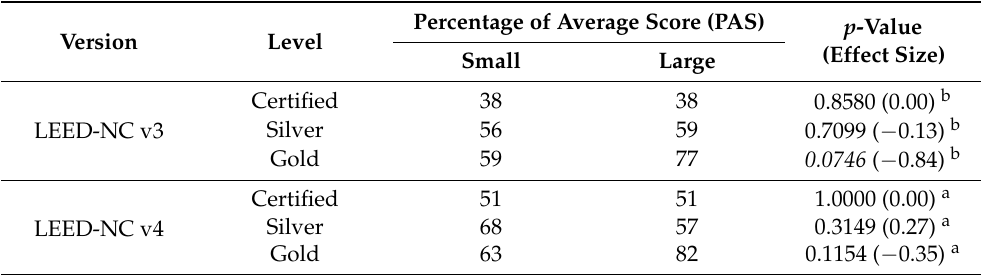
Table 12. LEED-NC v3/v4 office-type projects, enhanced commissioning credit.